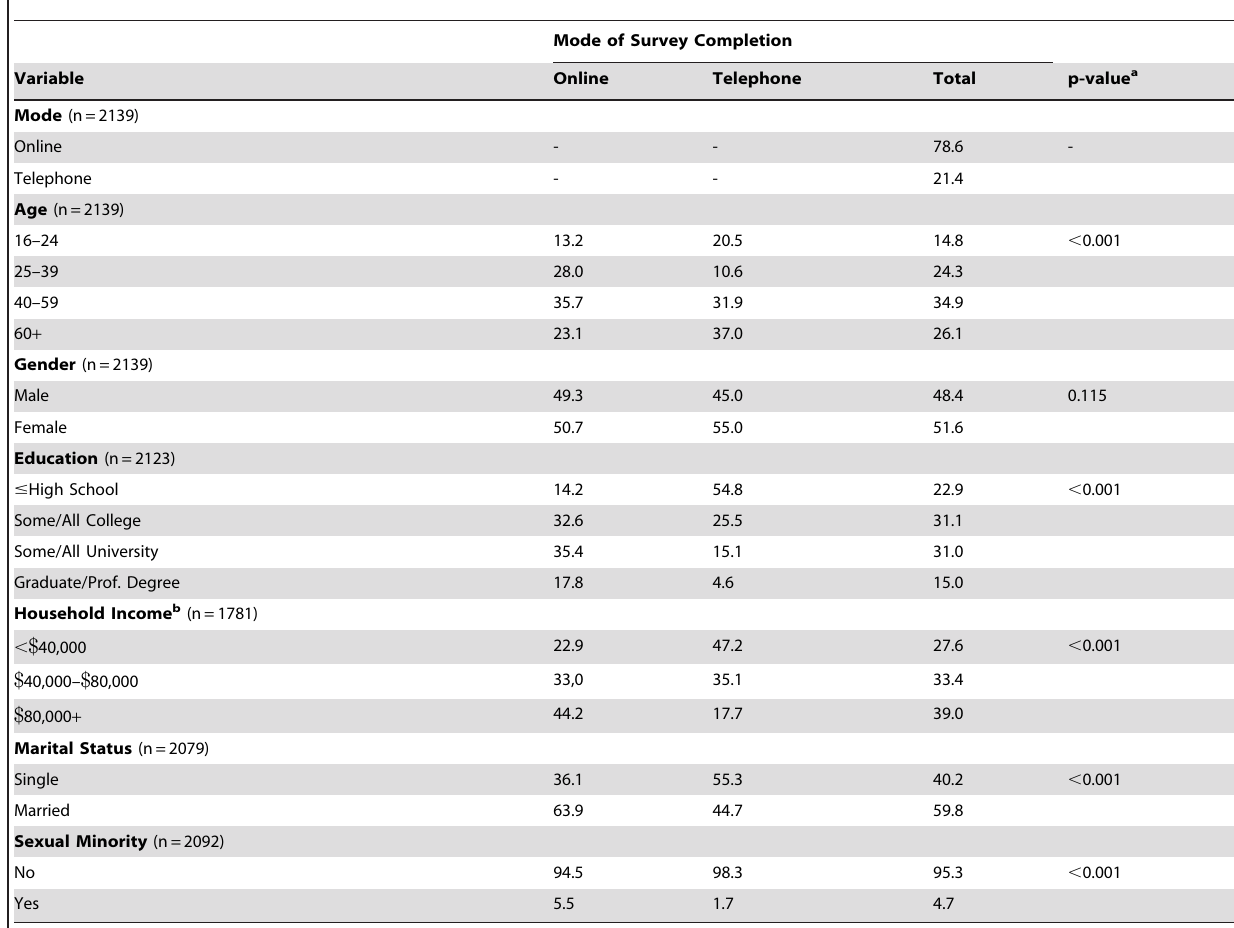
Table 2. Socio-demographic Characteristics and Mode of Survey Completion, Overall Sample (n= 2139, Weighted